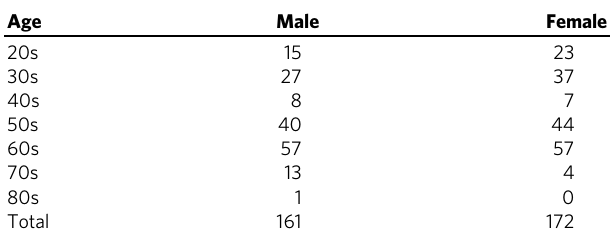
Table 1 Number of individuals analyzed in this